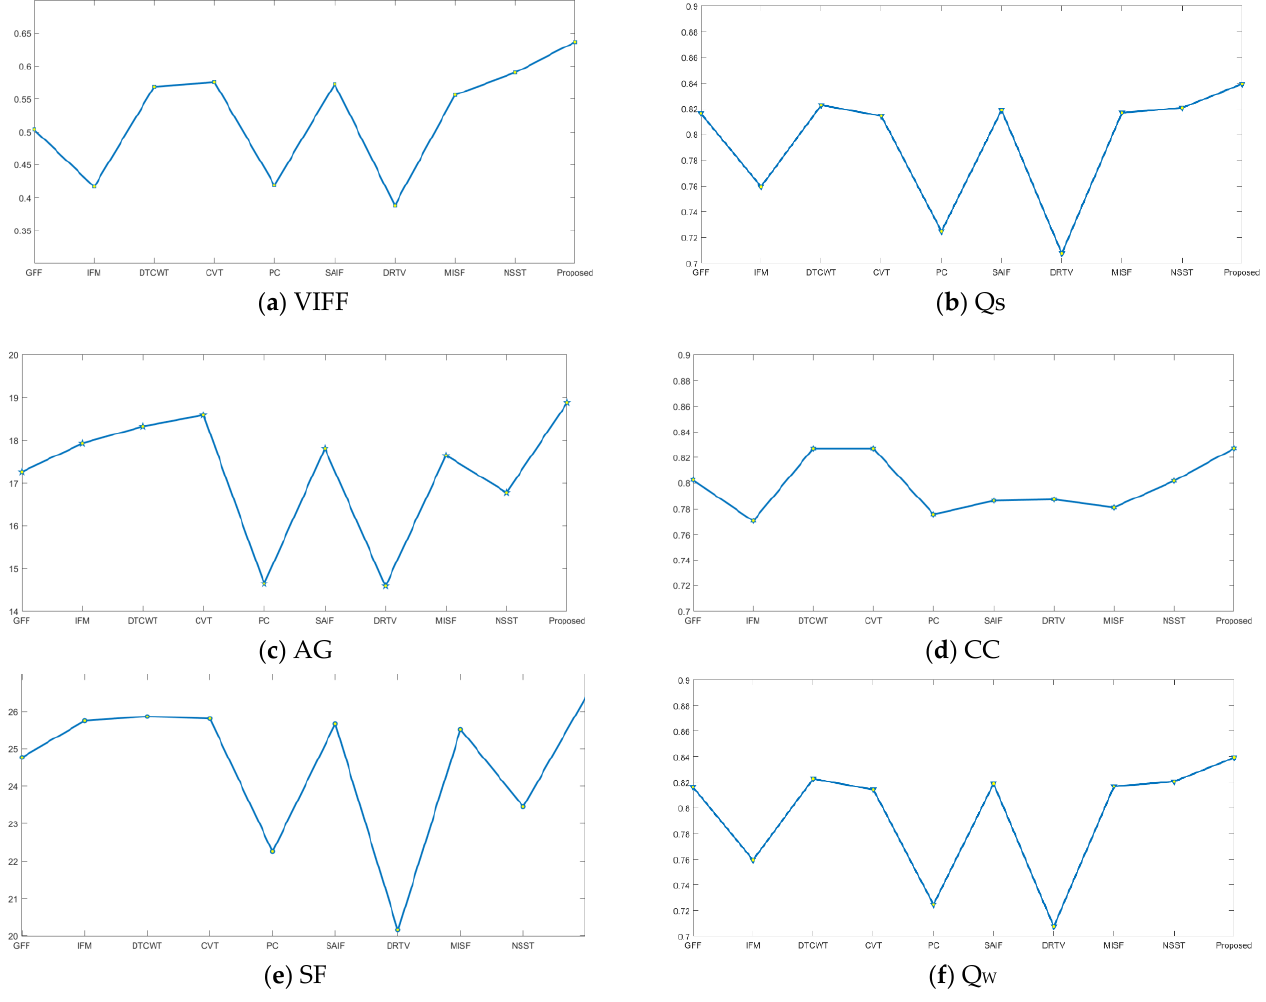
Figure 8. The line chart of objective metric data in Table 5. ( a ) VIFF; ( b ) Q S ; ( c ) AG; ( d ) CC; ( e ) SF; ( f ) Q W .